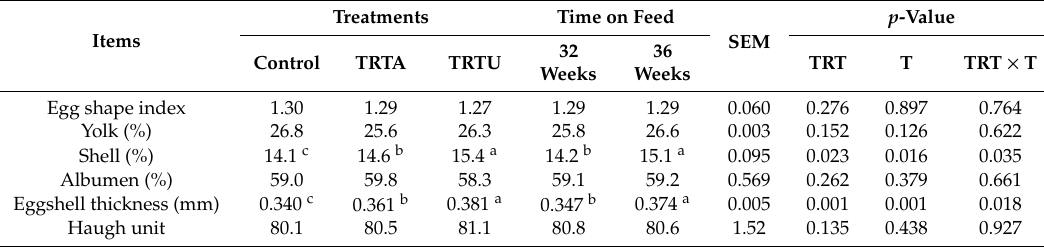
Table 3. E ff ects of dietary U. cannabina supplementation on the egg quality of laying hens.